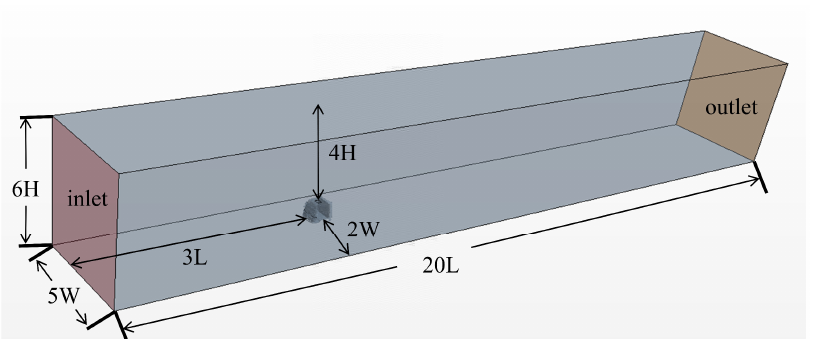
Figure 2. The wind tunnel calculation domain.